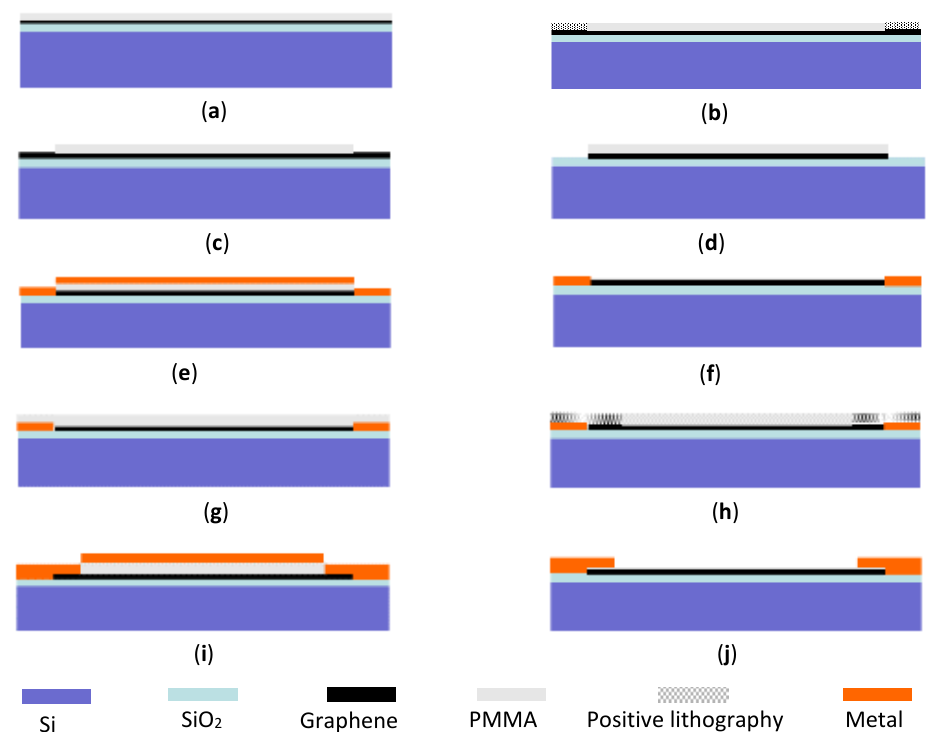
Figure 3. A schematic diagram of the source and drain electrode production process. ( a ) Spin-coating positive photoresist ( b ) Electron-beam lithography ( c ) Positive photoresist development ( d ) ICP etching ( e ) First evaporation of metal ( f ) Stripping ( g ) Spin-coating positive photoresist ( h ) Electron-beam lithography ( i ) Second evaporation of metal ( j ) Stripping.